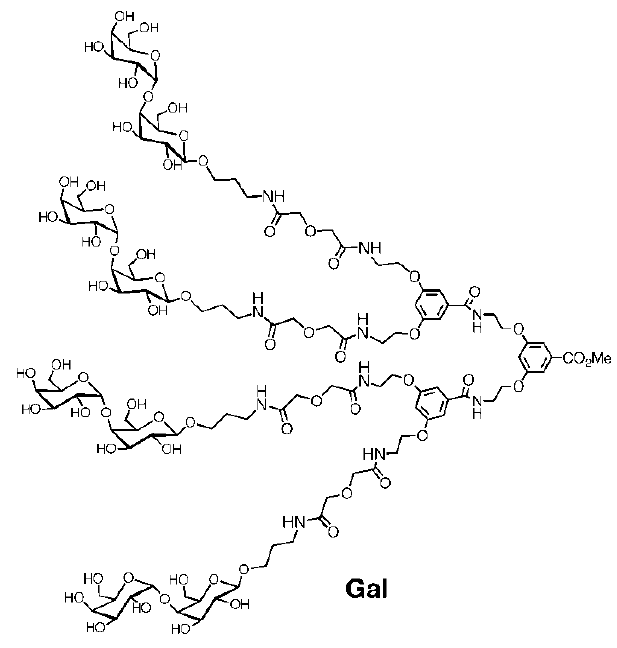
Figure 1. (cid:54)(cid:87)(cid:85)(cid:88)(cid:70)(cid:87)(cid:88)(cid:85)(cid:72)(cid:3)(cid:82)(cid:73)(cid:3)(cid:87)(cid:75)(cid:72)(cid:3)(cid:87)(cid:72)(cid:87)(cid:85)(cid:68)(cid:89)(cid:68)(cid:79)(cid:72)(cid:81)(cid:87)(cid:3)(cid:74)(cid:68)(cid:79)(cid:68)(cid:69)(cid:76)(cid:82)(cid:86)(cid:72)(cid:3)(cid:70)(cid:82)(cid:80)(cid:83)(cid:82)(cid:88)(cid:81)(cid:71)(cid:3)(cid:181)(cid:42)(cid:68)(cid:79)(cid:182)